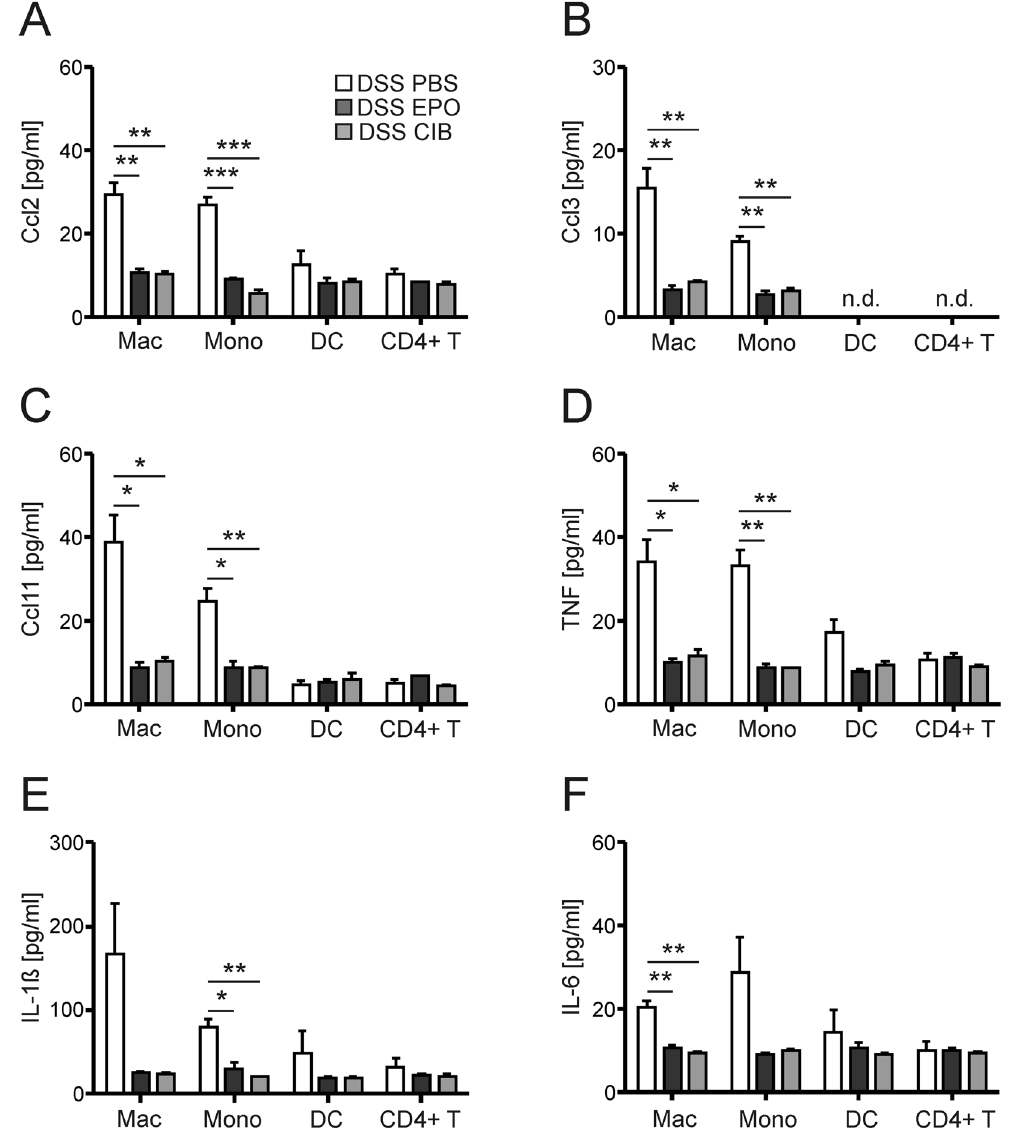
Figure 4. EPO and cibinetide inhibit chemokine and cytokine production by myeloid cells. The indicated immune cell populations were FAC-sorted from the lamina propria of DSS-exposed mice and cells were cultured for 24 hrs to allow for ex vivo mediator secretion. Concentrations of Ccl2 ( A ), Ccl3 ( B ), Ccl11 = Eotaxin; depicted in ( C ), TNF ( D ), IL-1ß ( E ) and IL-6 ( F ) were measured by specific ELISA kits. Data are from 3 to 4 individual mice and were compared using the unpaired student’s t-test. * p < 0.05, ** p < 0.01, *** p < 0.001 as compared to DSS/PBS stimulation. n.d. denotes not